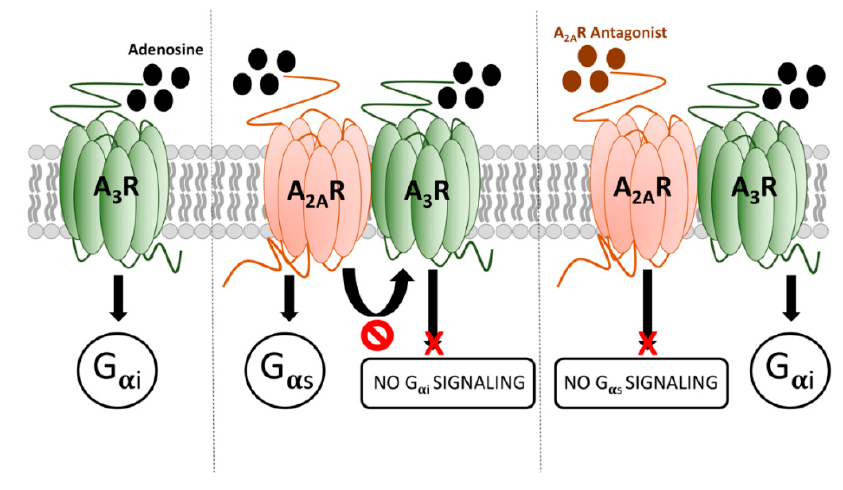
Figure 5. Scheme summarizing the signaling output of adenosine when interacting with A 2A R/A 3 R-